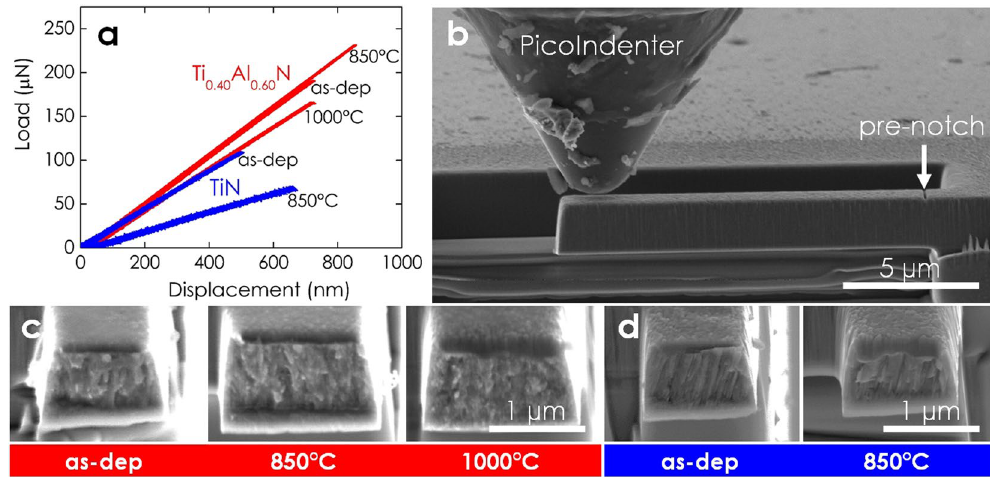
Figure 4. ( a ) Representative force–deflection curve of free-standing ( ex-situ ) annealed TiAlN cantilevers recorded during testing inside the scanning electron microscope. ( b ) The small dimension of the coating